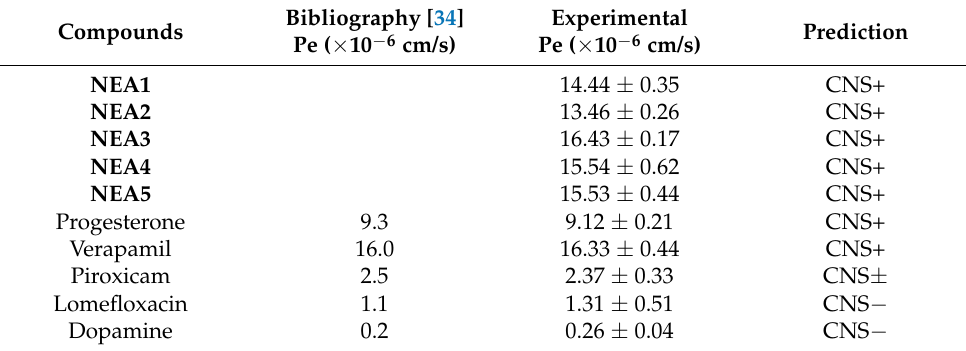
Figure 4. The best-docked poses of compounds NEA1 ( a , green sticks) and NEA3 ( b , yellow sticks) in a MAO-B binding pocket. Green lines indicate p–p contacts. Black wireframes report the original pose of MAO-B sidechains within the bind- ing site. As for the MAO-B binding pocket, NEA1 and NEA3 assumed a similar binding mode within the MAO-B active site. The para- nitro aromatic ring of NEA1 was able to make p– p contact with the MAO-B selective residue, Y326, and the phenyl ring that resulted was placed in a network of hydrophobic interactions with FAD, Y435, and Y398, the latter also being involved in p–p contact. Regarding the binding mode of NEA3 , the para- nitro aro- matic ring that resulted was sandwiched between Y326 and F168. Furthermore, the para- fluorine ring was able to interact with Y398 through p–p contact, which resulted in it being